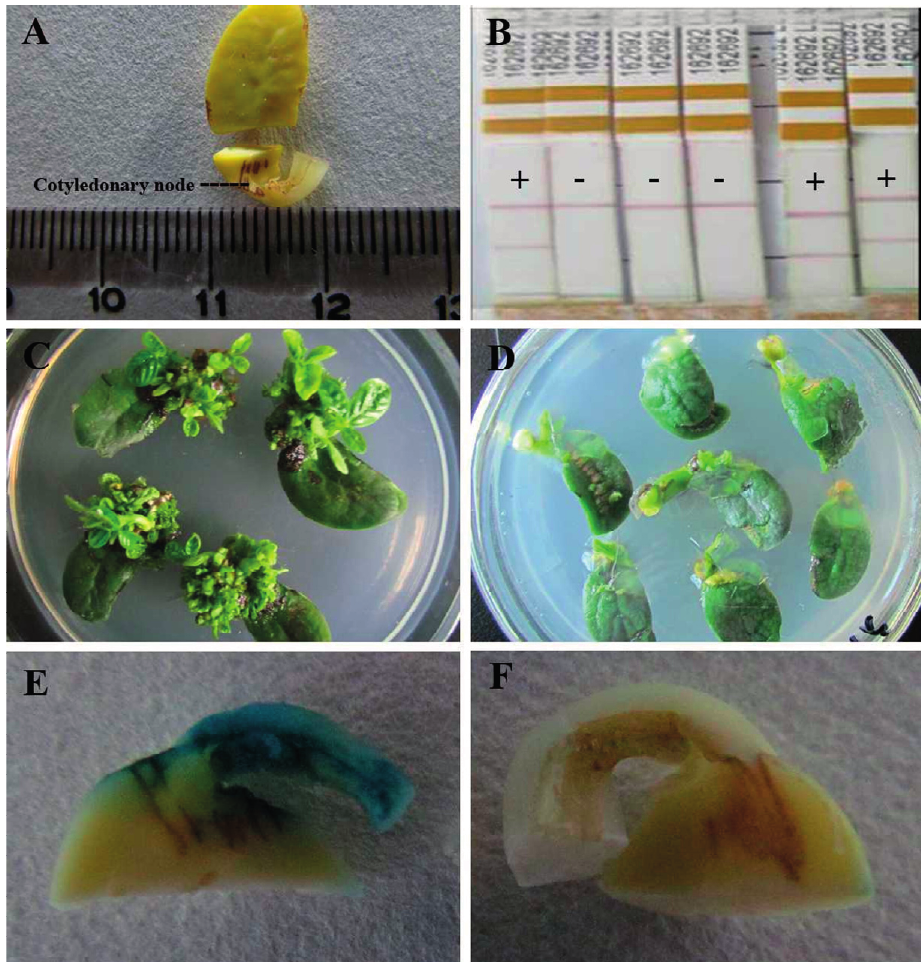
Figure 1. Cotyledonary node for determination, LibertyLink strip analysis of T 0 plants, phenotype of explants after shoot induction, and GUS staining after co-cultivation for five days. ( A ) Sampling standard of cotyledonary node, numbers on the ruler represent centimeters; ( B ) Transgenic soybean plants were tested using LibertyLink strips, +: positive T 0 plants, − : negative T 0 plants; ( C ) Explants with phosphinothricin-resistant multiple buds; ( D ) Explants with no buds; ( E ) Cotyledonary node after GUS staining dyeing; and ( F ) Cotyledonary node with no GUS staining. Table 2. Transient GUS expression in cotyledonary nodes from different soybean genotypes. No. of Cotyledonary Nodes No. of GUS + GUS + Rate (%) Genotype for GUS Staining Cotyledonary Nodes General 98